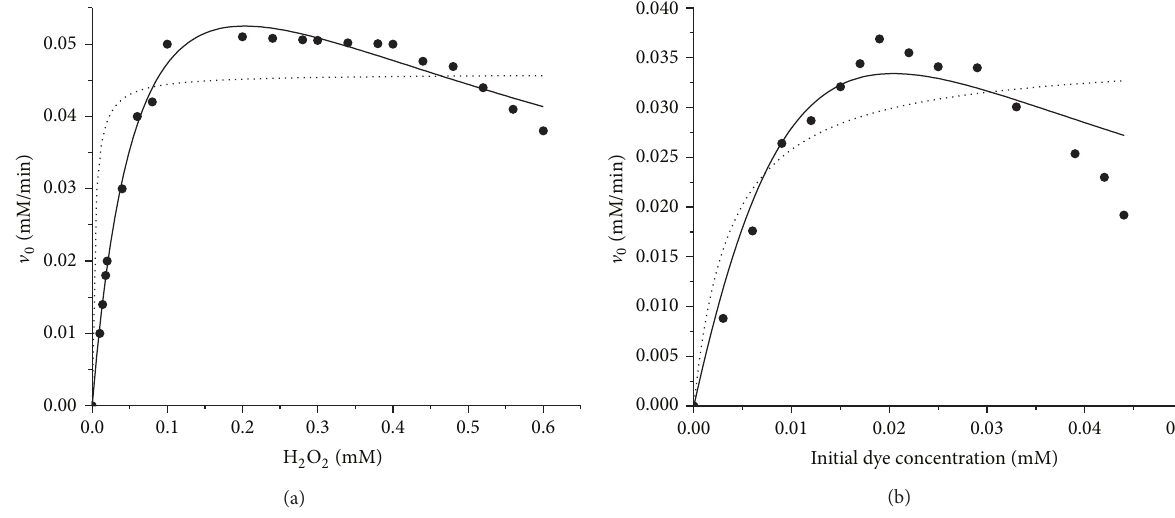
Figure 8: (a) Initial rate versus hydrogen peroxide concentration at fixed AB 225 concentration of 0.029 mM and (b) initial rate versus AB 225 concentration at fixed hydrogen peroxide concentration of 0.1mM. Symbols represent experimental data, lines indicate kinetic models based on fitted kinetic parameters including substrate inhibition (solid lines) and without substrate inhibition (dotted